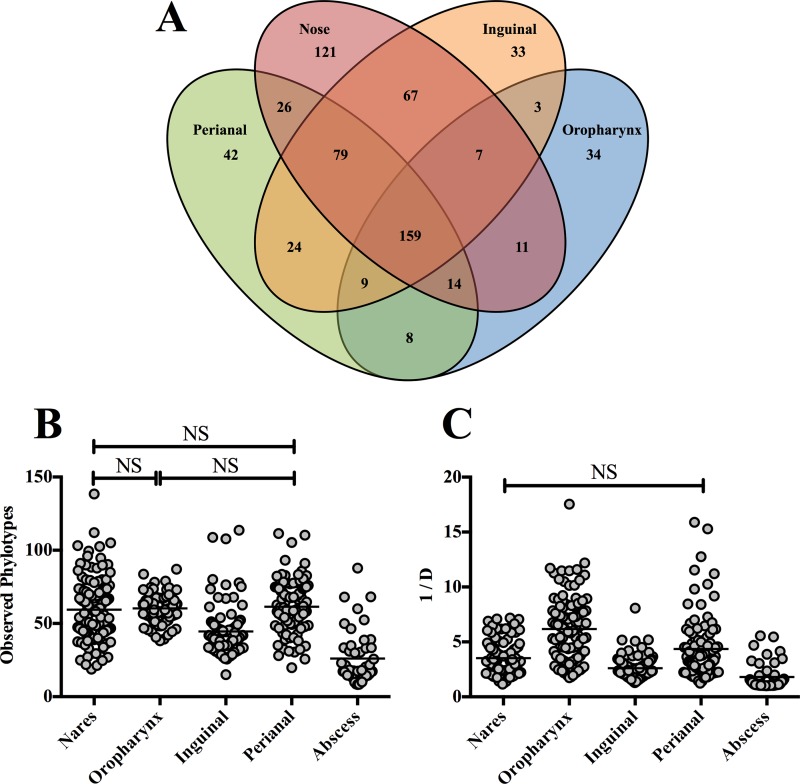
Phylotype distribution, richness, and diversity levels for the various body sites and abscesses. (A) Venn diagram showing the number of phylotypes at each body site. Values within overlapping circles represent phylotypes shared among those body sites. (B) Phylotype richness as assessed by the mean number of observed phylotypes per sample. (C) Sample diversity levels as determined using the invsimpson index (1/D). The higher the value, the more diverse the sample. For panels B and C, each circle represents a single sample and the mean values are indicated by a solid black line. All comparisons were statistically significant (P < 0.001) except for those marked with an NS (not significant).